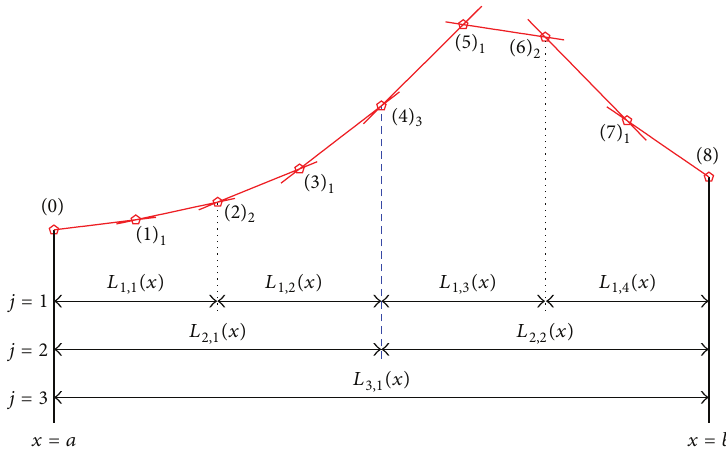
Figure 3: Illustration of the presented method for the case of 𝑛 = 3. The symbol (𝑡) 𝑗 denotes an interpolation point at the 𝑡 th node 𝑥 𝑡 which is smoothened by 𝐿 𝑗,𝑘 (𝑥) in the 𝑗 th smoothening